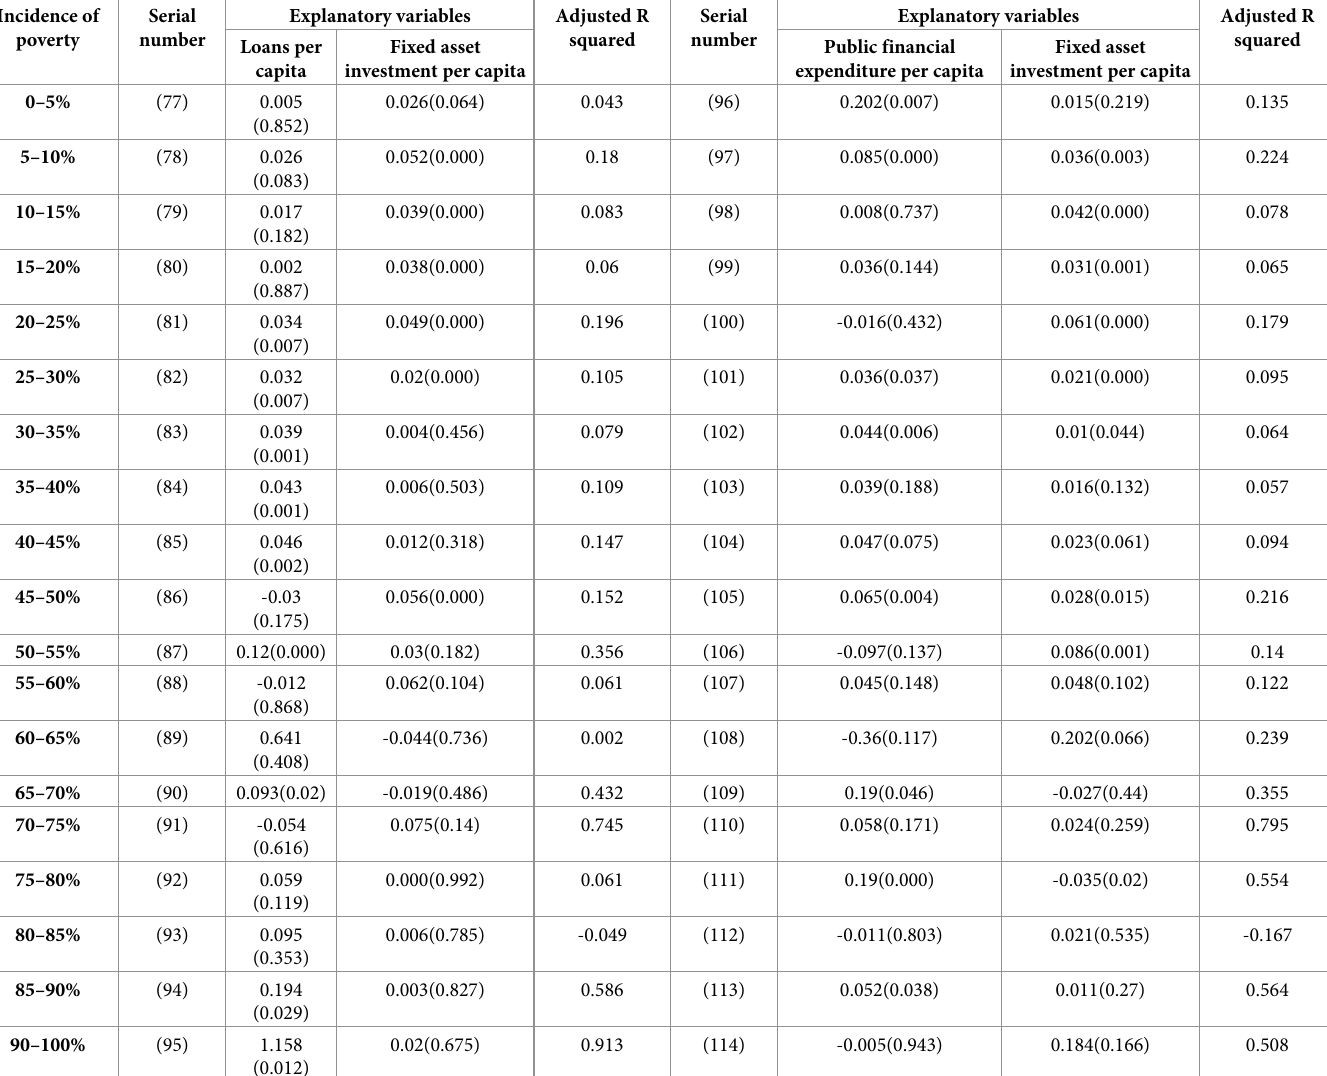
Table 6. The linear relationship between Rural Per Capita Income (dependent variable) and the Explanatory variables under different poverty incidence. Incidence of